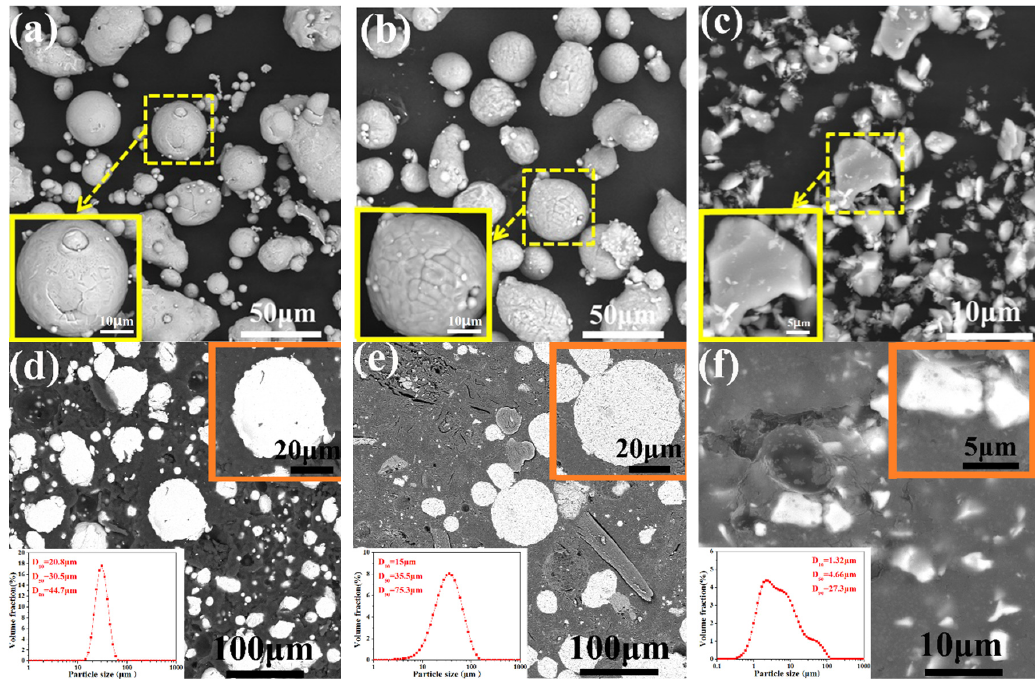
Figure 1. The surface and cross-sectional morphologies of the powders: ( a , d ) Ni, ( b , e ) Al, and ( c , f ) TiB 2 .